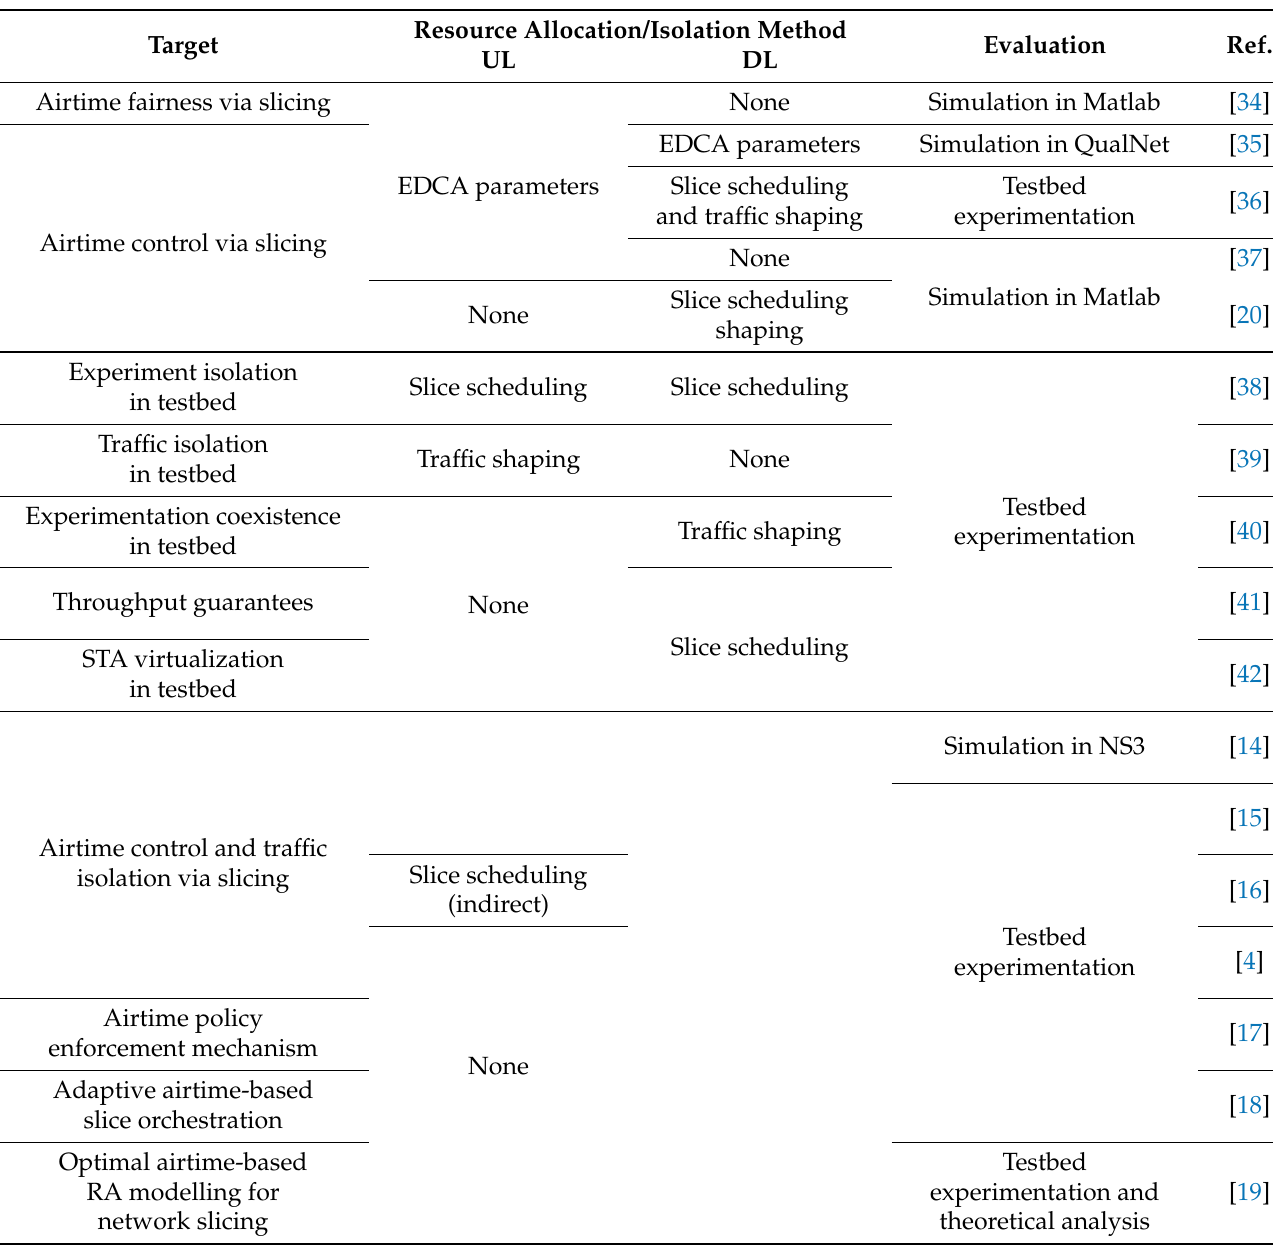
Table 1. Summary of the main network slicing proposals in the IEEE 802.11